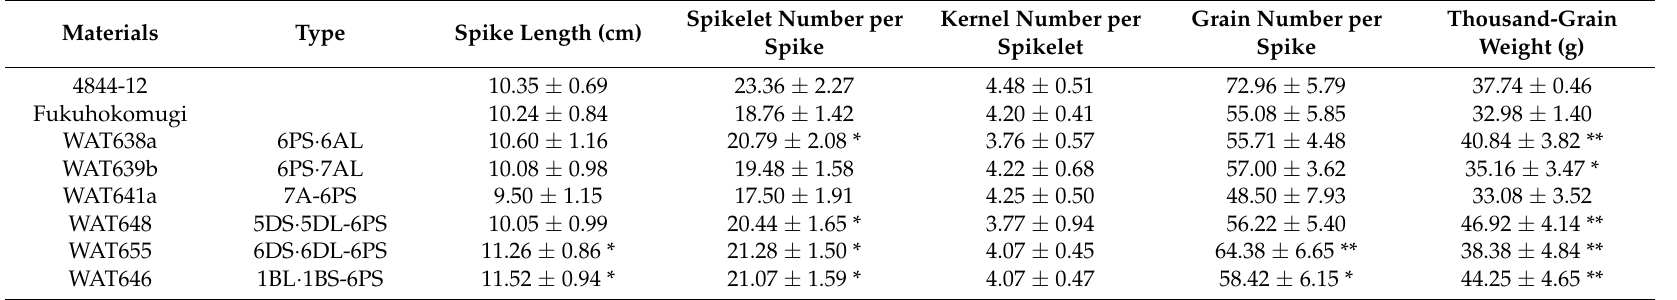
Table 3. Agronomic traits for stripe rust-resistant translocation lines and their parents in